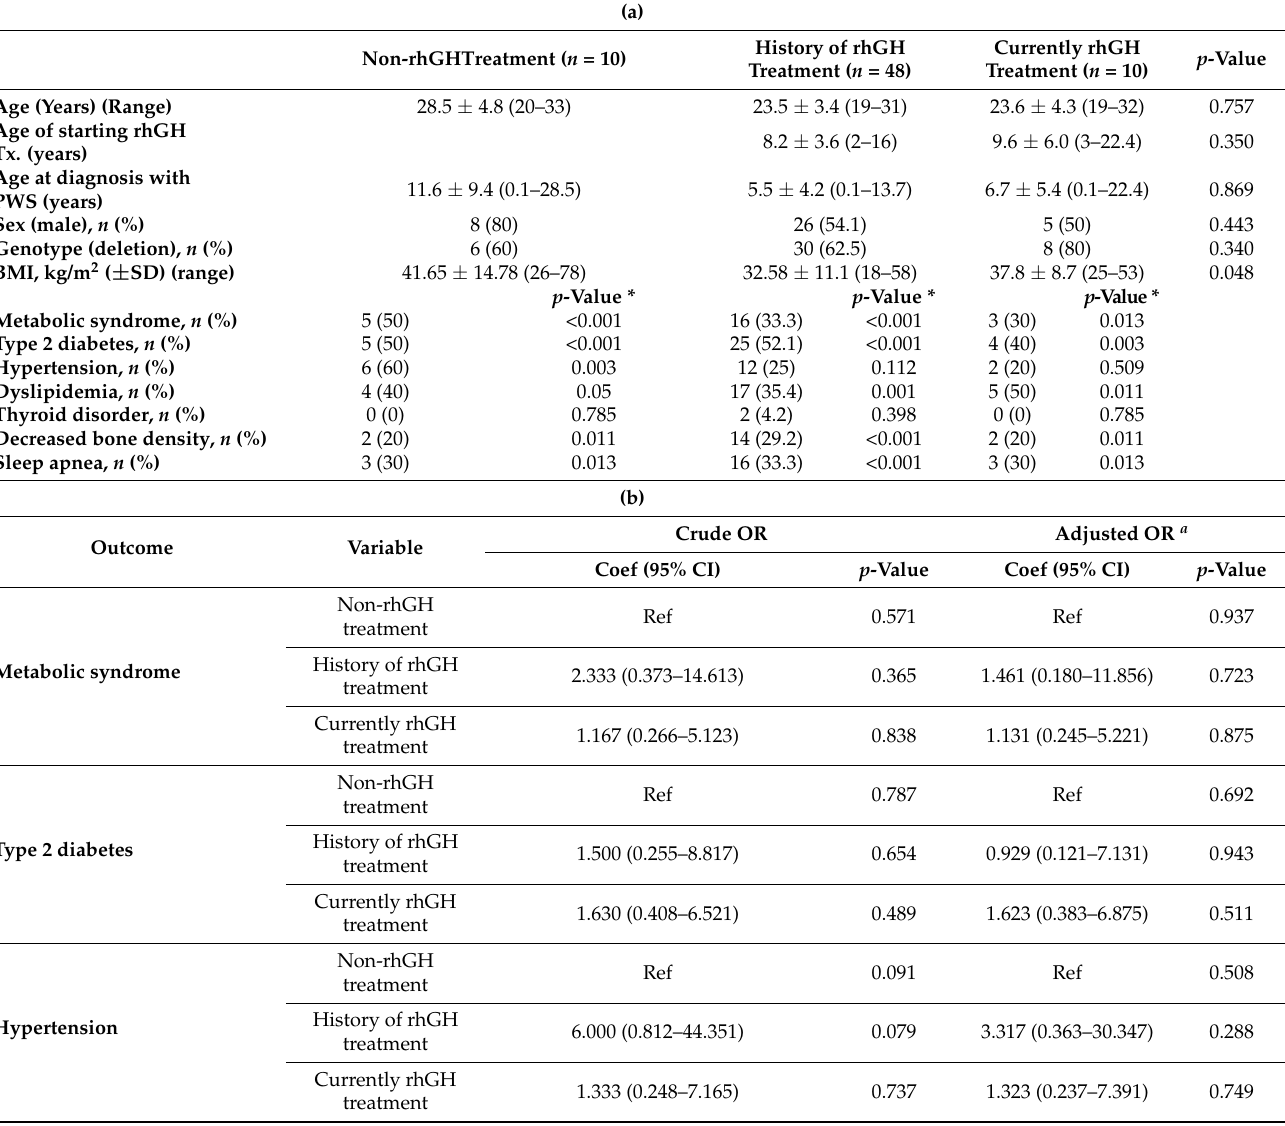
Table 4. ( a ) Demographic comparison. Metabolic and endocrine illnesses in young adults with PWS according to rhGH treatment, and comparison of age-, sex-, and BMI-matched healthy control group with each group. ( b ) Logistic regression model assessing the association of metabolic and endocrine illnesses with rhGH, crude- and age- and sex-adjusted for PWS